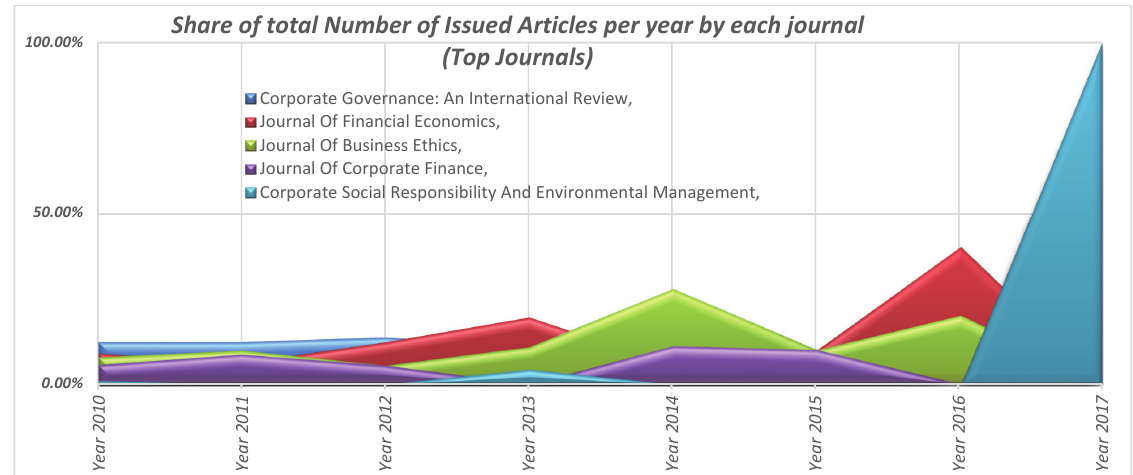
Fig. 3. Share of total Number of Issued Articles per year by each